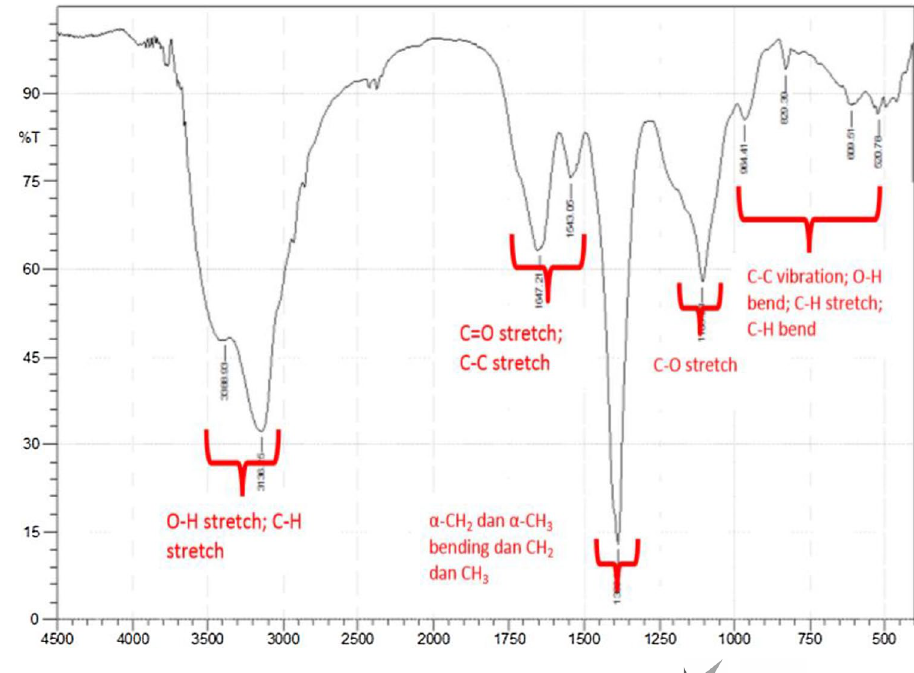
Fig. 4 IR spectra of Pseudoxan- thomonas sp. G3